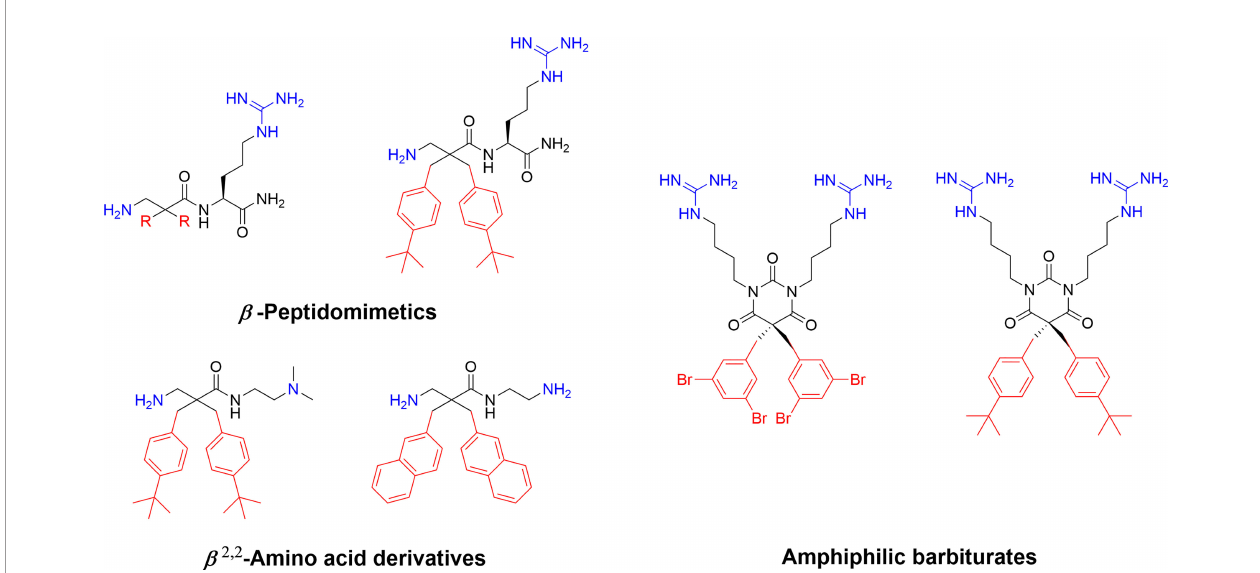
FIGURE 5 | Examples of highly active antimicrobial b -peptidomimetics, b 2,2 -amino acid derivatives and amphiphilic tetrasubstituted barbiturates develop by Strøm and co-workers (67, 68, 85). The peptidomimetics illustrate how the AMP pharmacophore effectively can be transferred to smaller